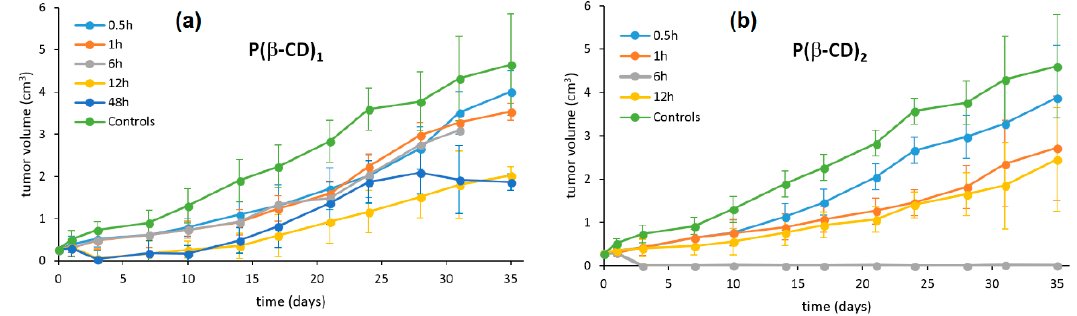
Figure 19. Effects of ( a ) P( β -CD) l - and ( b ) P( β -CD) 2 -mediated PDT on tumor growth. BALB/c mice bearing subcutaneously growing 4T1 mammary carcinoma ( n = six per each group) received a single dose of the drug (5 mg/kg) and were then irradiated (100 J/cm 2 , 200 mW/cm 2 ) at indicated time points. The control group consisted of untreated tumor bearing mice. Adapted from Králová; Synytsya; Pouckova; Koc; Dvorak; Kral [139].